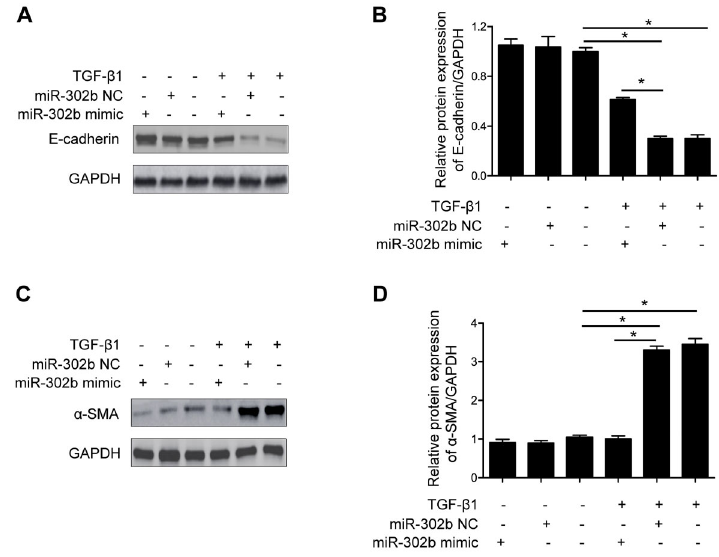
Figure 3. MiR-302b suppressed TGF- b 1-induced epithelial mesenchymal transition (EMT) in HK-2 cells. Representative western blot images of E-cadherin ( A ) and a -SMA ( C ) in HK-2 cells treated with miR-302b negative control sequences (miR-302b NC, 20 nM) or mimics (miR-302b mimic, 20 nM ) with or without TGF- b 1 (5 ng/mL) treatment for 48 h. Quantitative analysis of E-cadherin ( B ) and a -SMA ( D ) protein expression levels. Data are reported as means ± SE (n=8). *P o 0.05